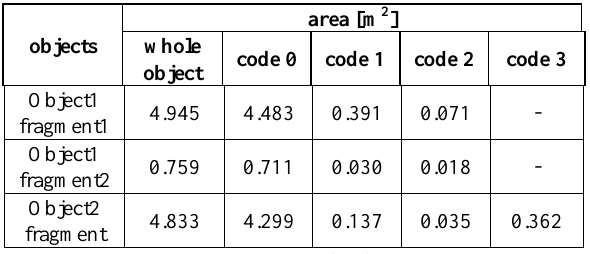
Table 4. Area of defects